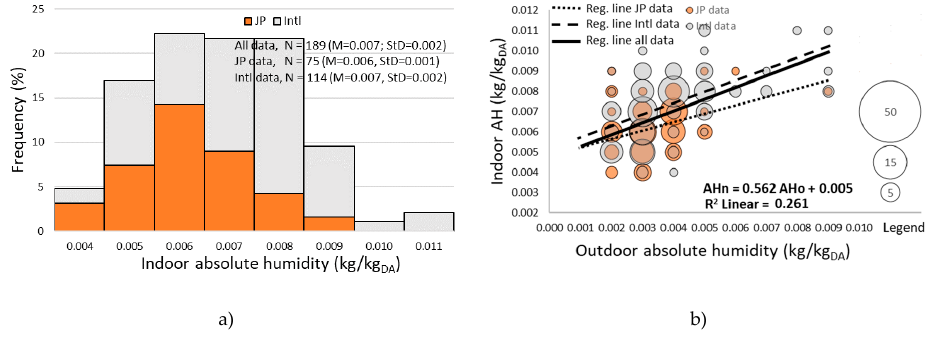
Figure 6. Indoor and outdoor absolute humidity at TSV ( − 1, 0, + 1): ( a ) Frequency percentage distribution of neutral indoor absolute humidity; ( b ) correlation between indoor and outdoor absolute humidity at the vote.